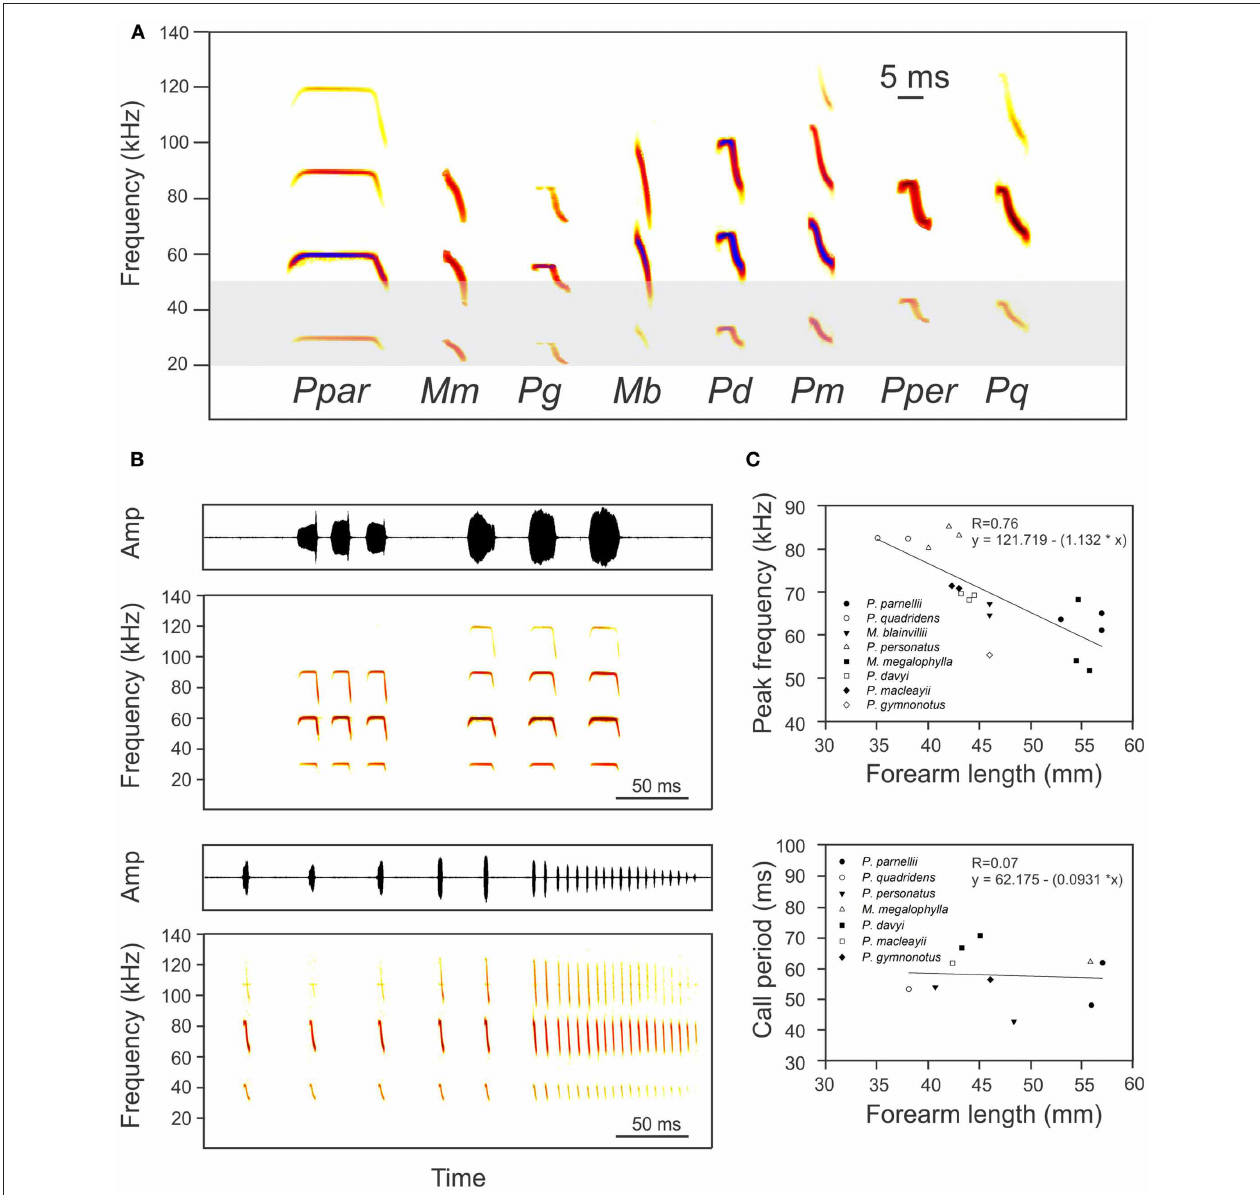
FIGURE 3 | (A) Spectrograms of typical search calls of the eight bat species of the family Mormoopidae (Ppar: Pteronotus parnellii , Mm, Mormoops megalophylla ; Pg, Pteronotus gymnonotus ; Mb, Mormoops blainvillei ; Pd, Pteronotus davyi ; Pm, Pteronotus macleayii ; Pper, Pteronotus personatus ; Pq, Pteronotus quadridens ). The light-gray area represents the frequency range of best audition in eared moths, after Fullard (1988). (B) Typical echolocation sequence (oscillogram and spectrogram) emitted by P. parnellii (up) and P. quadridens (down) during foraging. Note that call harmonics never overlap. (C) Relationships